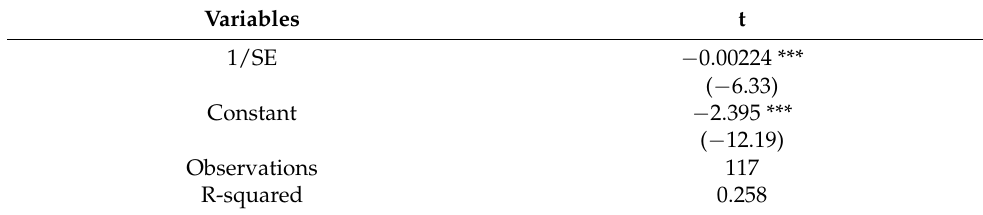
Table 2. Results of the funnel asymmetry test (FAT).